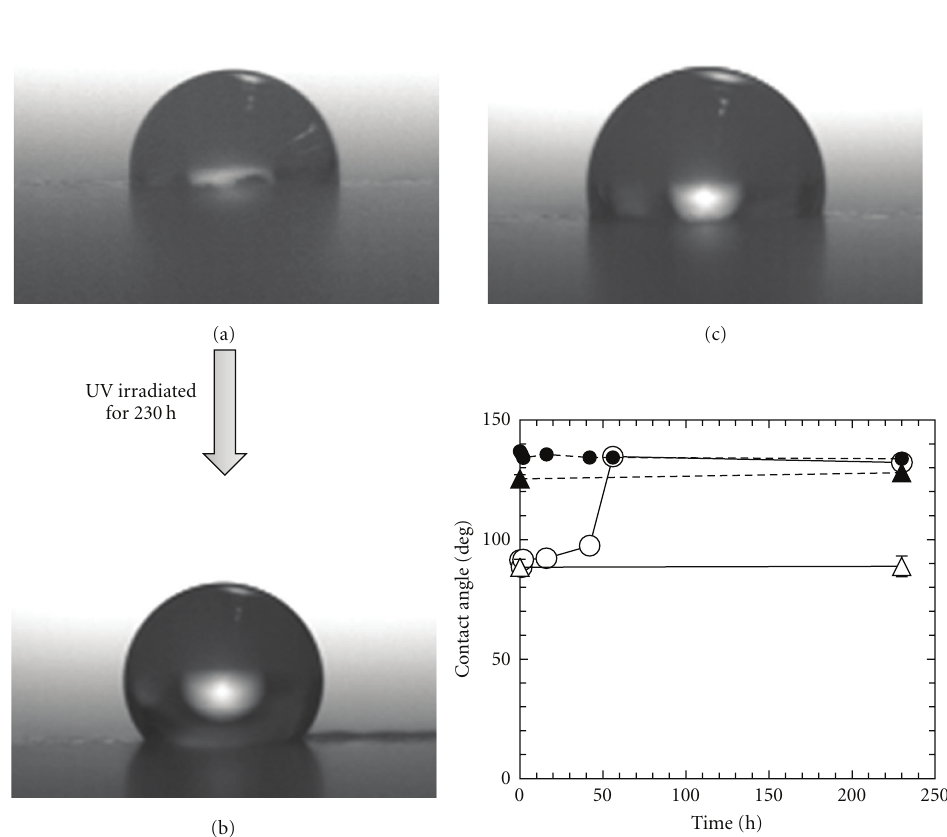
Figure 7: Recovery of water contact angles for N-doped TiO 2 -PTFE hydrophobic composite coating contaminated with 0.5 vol.% oleic acid diluted in n -heptane, during exposure to 1mW · cm − 2 of UV-A light for 230 hours. A PTFE composite coating without the addition of N-doped TiO 2 was used as the control sample. (a) water droplet on the PTFE plus 12% NT surface without UV illumination. (b) water droplet on the PTFE plus 12% NT after UV illumination. (c) water droplet on the control sample after UV illumination for 23 hours. Graph symbols represent (cid:2) : PTFE plus 12% NT, Oleic acid ( − ); (cid:5) : PTFE plus 12% NT, Oleic acid (+); (cid:2) : Control, Oleic acid ( − ); Oleic acid